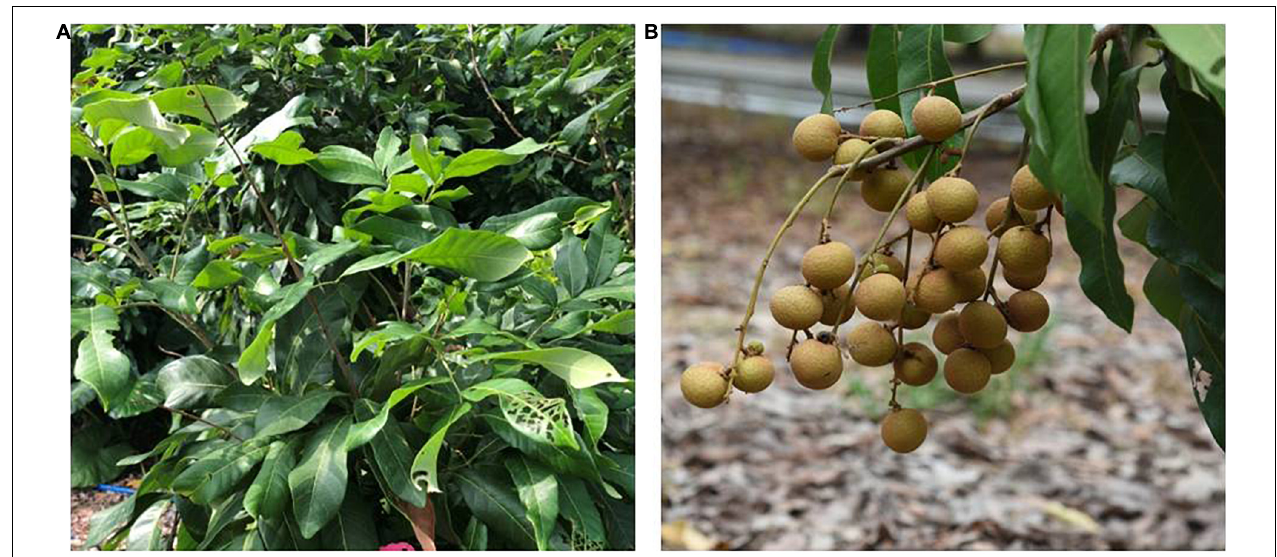
× Shixia (YS) showing no fruiting. (B) Shixia ♀ ♂